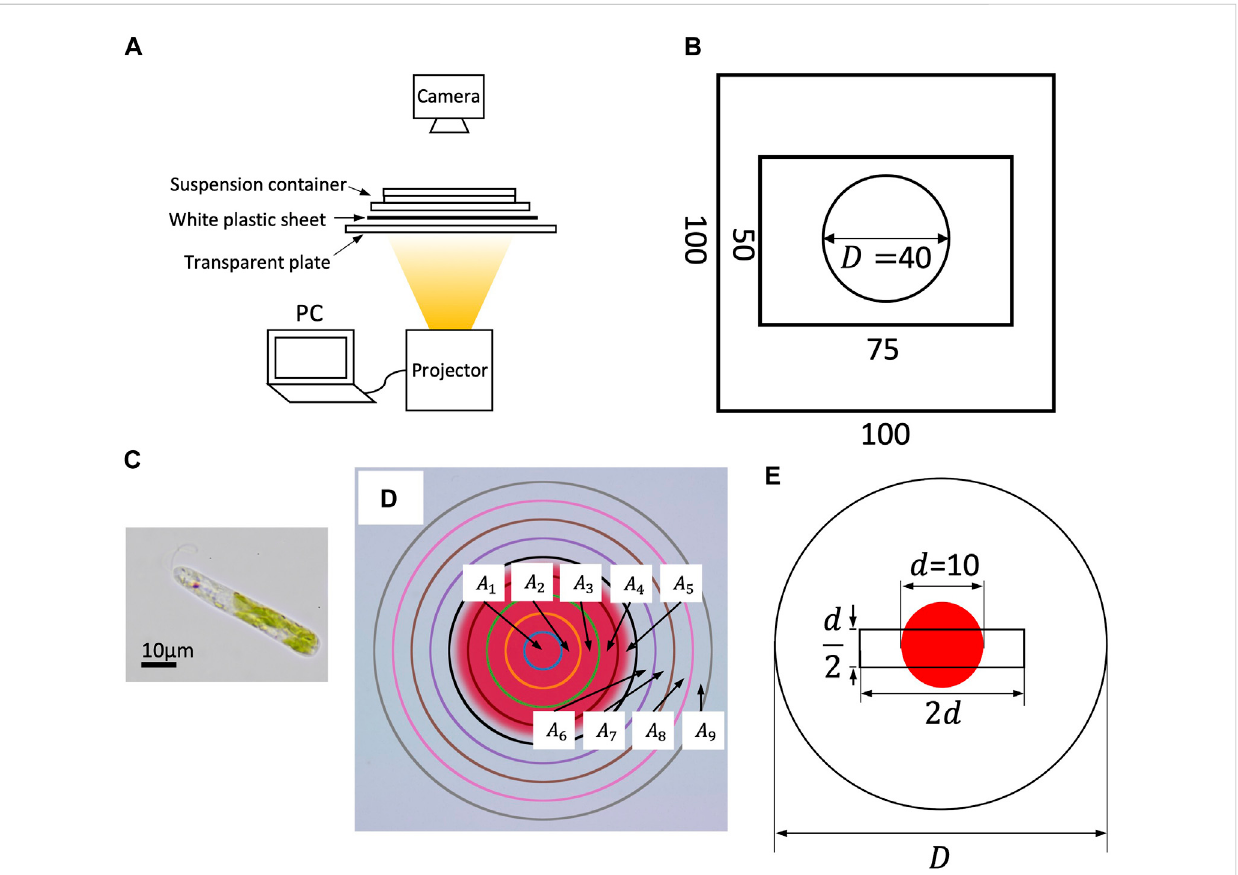
FIGURE 1 (A) Experimental setup. (B) Dimensions of suspension container. A silicone plate with 0.5 mm thickness is sandwiched between two rectangular glass plates. The suspension is put inside the circle (cylinder). (C) An image of E. gracilis . (D) Sub-regions for cell counting. (E) The search region of orbit analysis (a d /2×2 d rectangle).